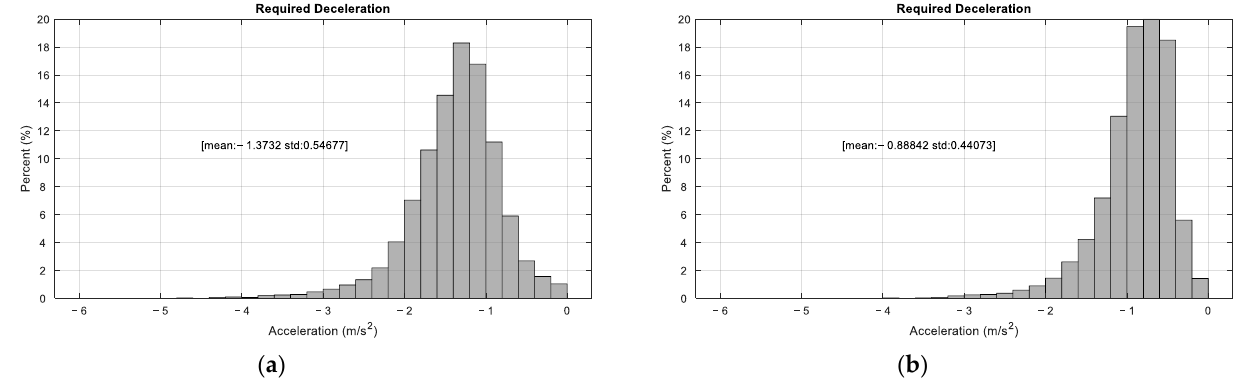
Figure 7. Distribution of required deceleration (300 random vehicles): ( a ) case of braking start point; ( b ) case of sailing start point.